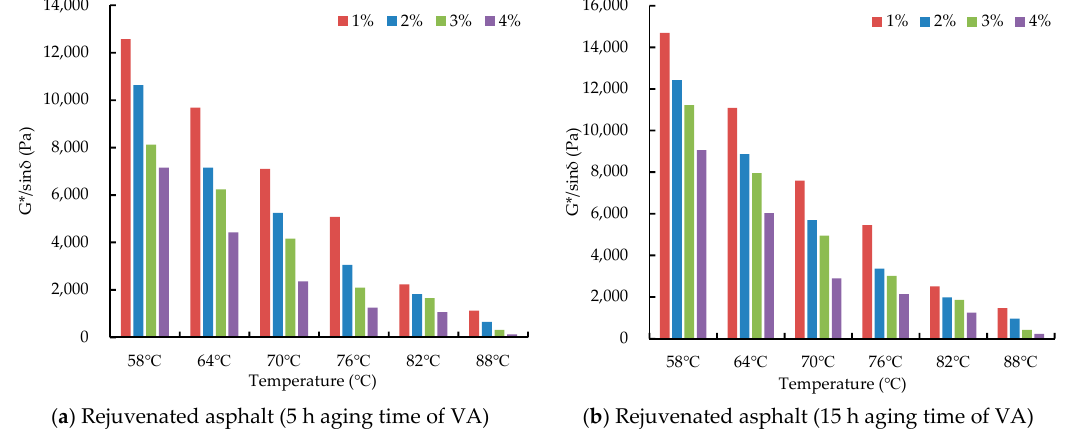
Figure 15. Influences of WEO on rutting resistance factor of rejuvenated asphalt (different aging time of VA).